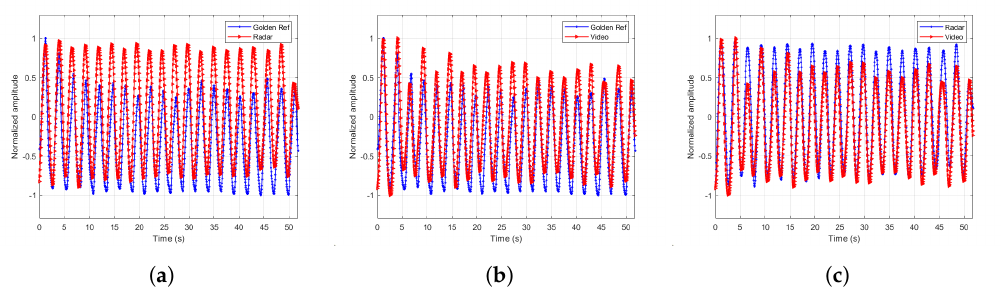
Figure 8. Extracted signals comparisons for breathing rate of 23.43 BPM. ( a ) Radar and ground truth signals. ( b ) RGB and ground truth signals. ( c ) Radar and RGB signals.